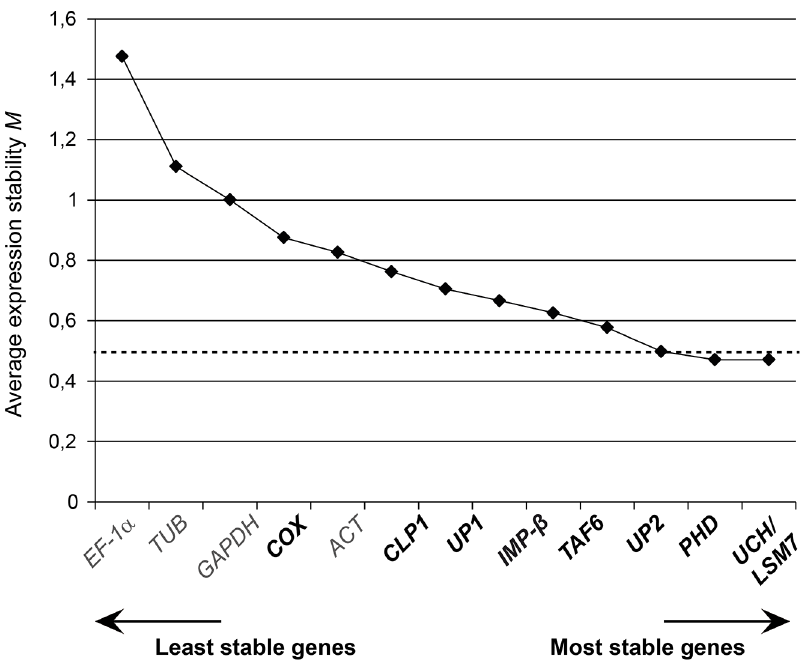
Fig 7. Expression stability of candidate reference genes in Xcv -infected and mock-treated pepper plants evaluated by geNorm. Ranking of C . annuum reference genes based on expression stability calculated by geNorm. New reference gene candidates are indicated in bold. M values represent the average expression stability of each gene (n = 48). The cut-off value for reliable reference genes is indicated by a dashed